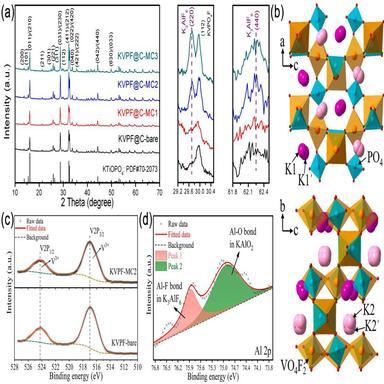
Structural analysis of KVPO4F-based samples: (a) Powder XRD pattens; (b) Crystal structure of the KVPO4F; (c) High-resolution XPS spectra of V2p of KVPF@C-bare and KVPF@C-MC2; (d) High-resolution XPS spectrum of Al2p of KVPF@C-MC2.